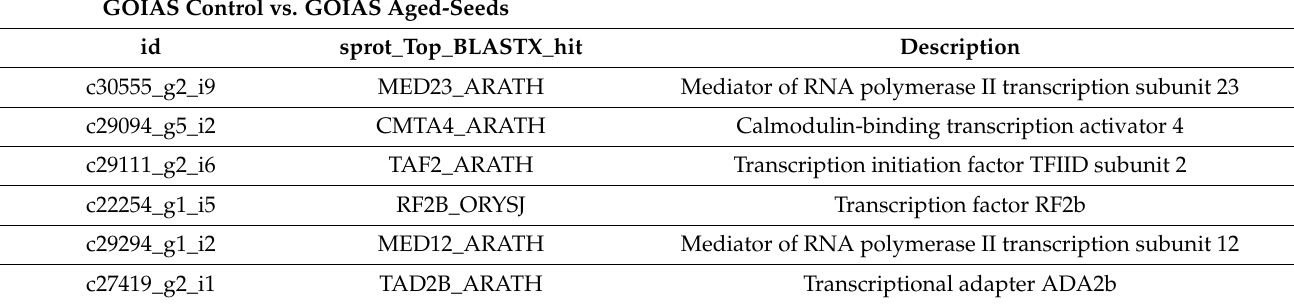
Table 4. Transcription-related factors identified as differentially expressed in the different treatments in this study of A. fraxinifolium .